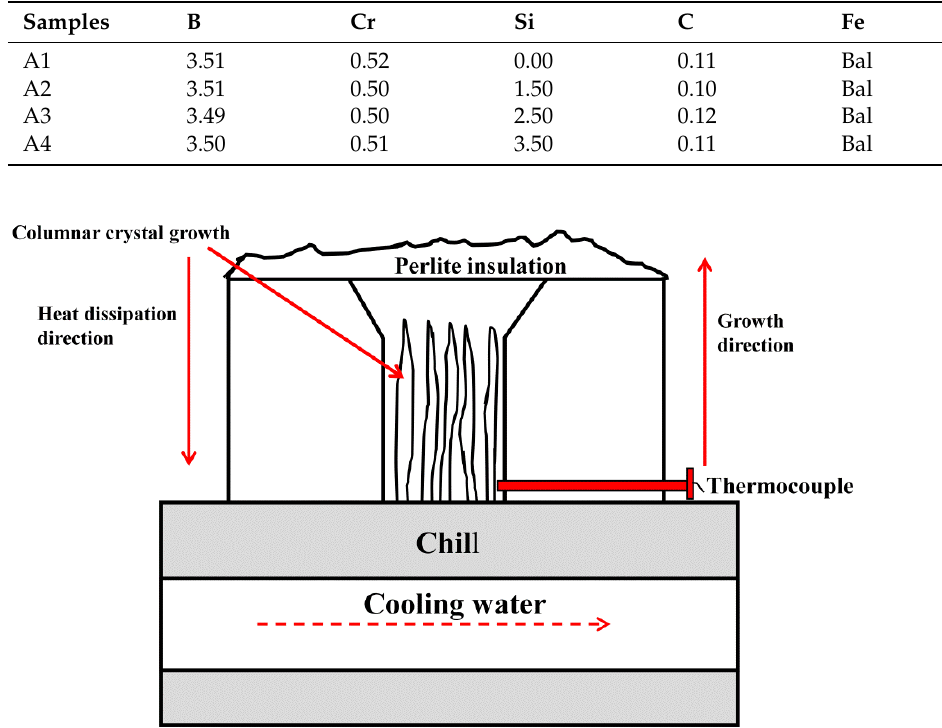
Figure 1. The schematic device of DS (directionally solidified) cast Fe – B alloy.